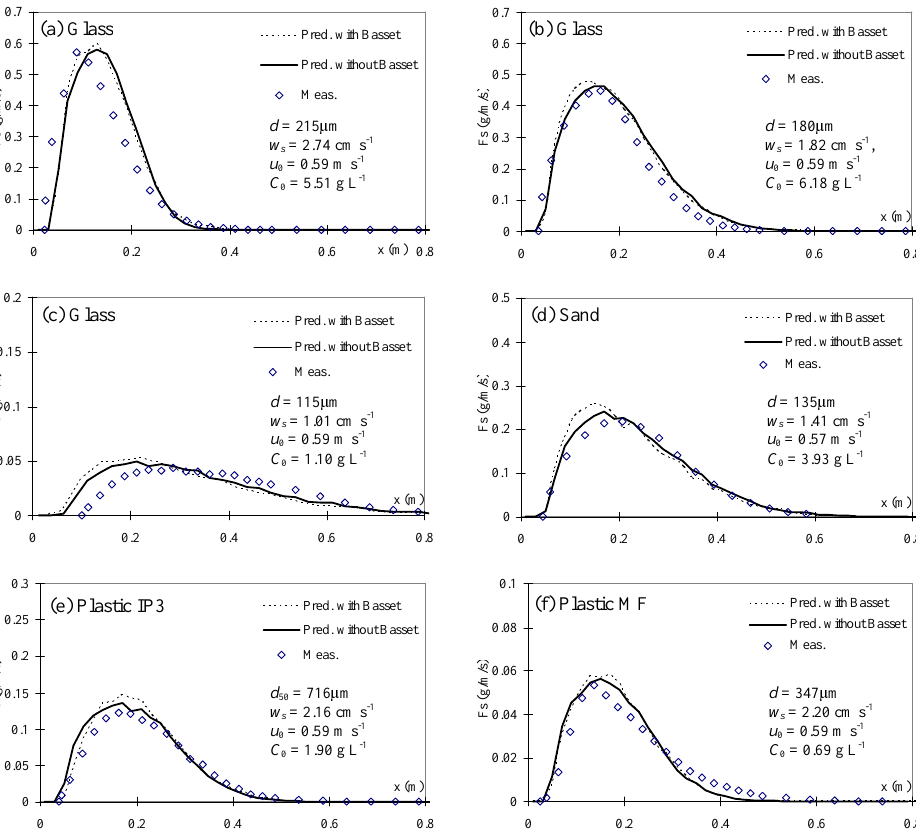
Figure 3. Comparison of predicted and measured 1-D bottom deposition profiles (transversely lumped), with and without the Basset force term.